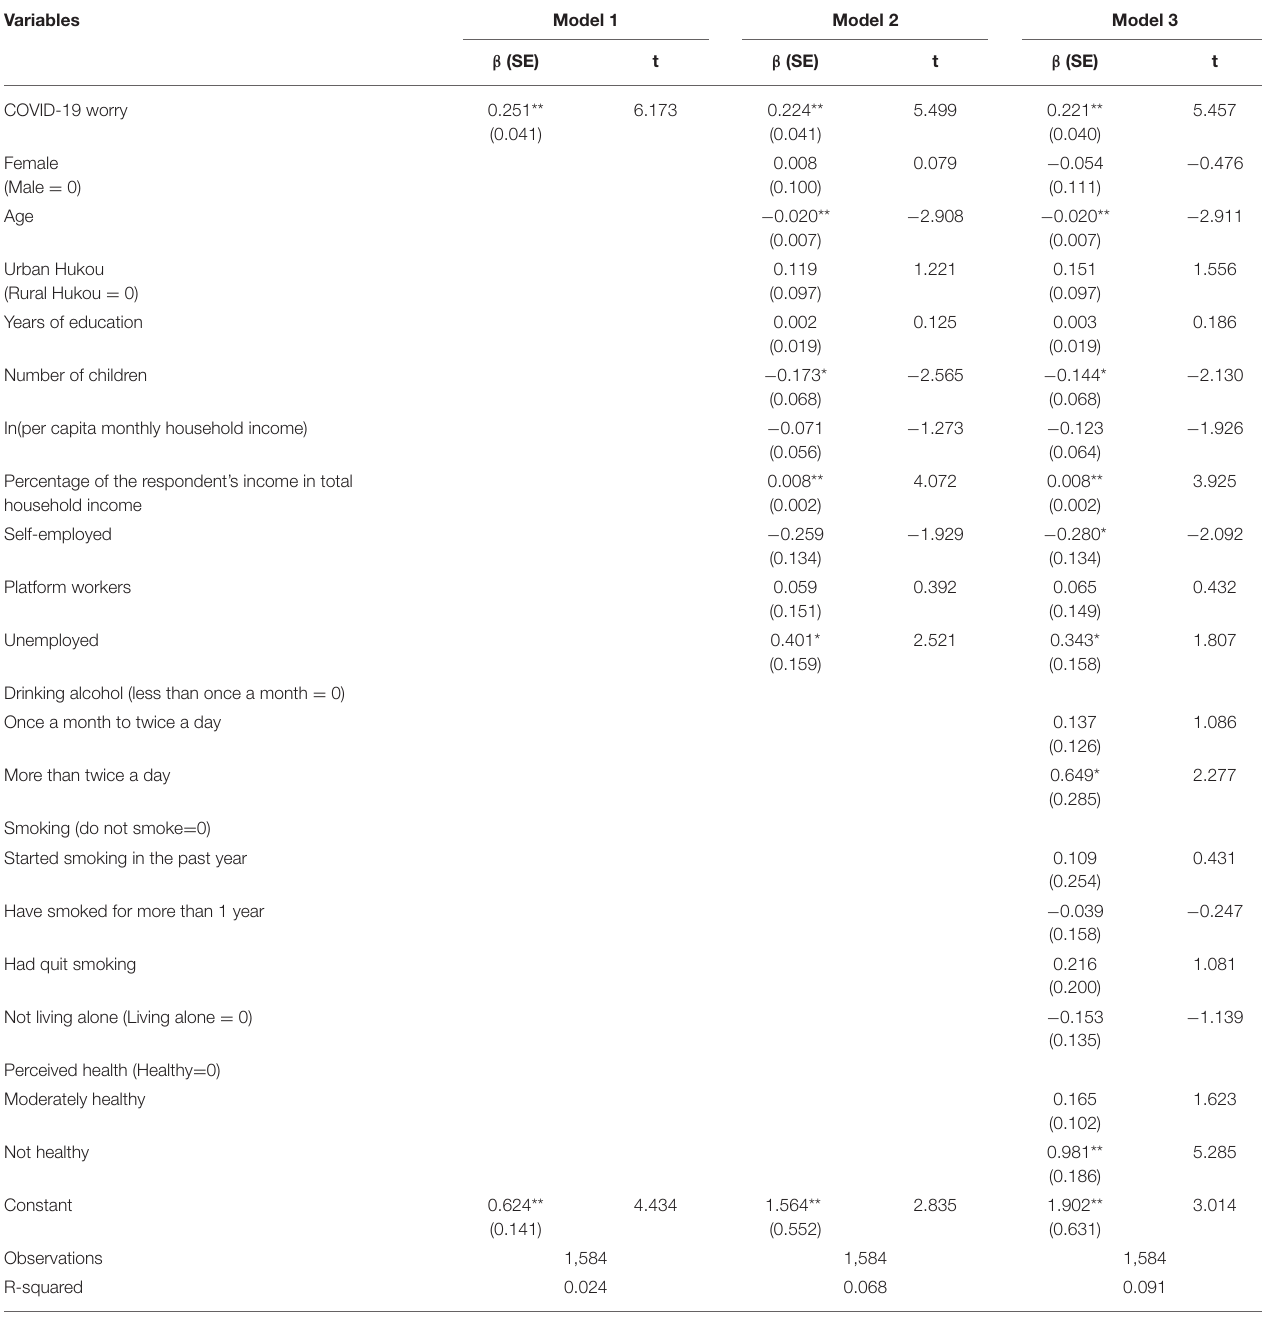
TABLE 3 | Effect of COVID-19 worry on the mental health of